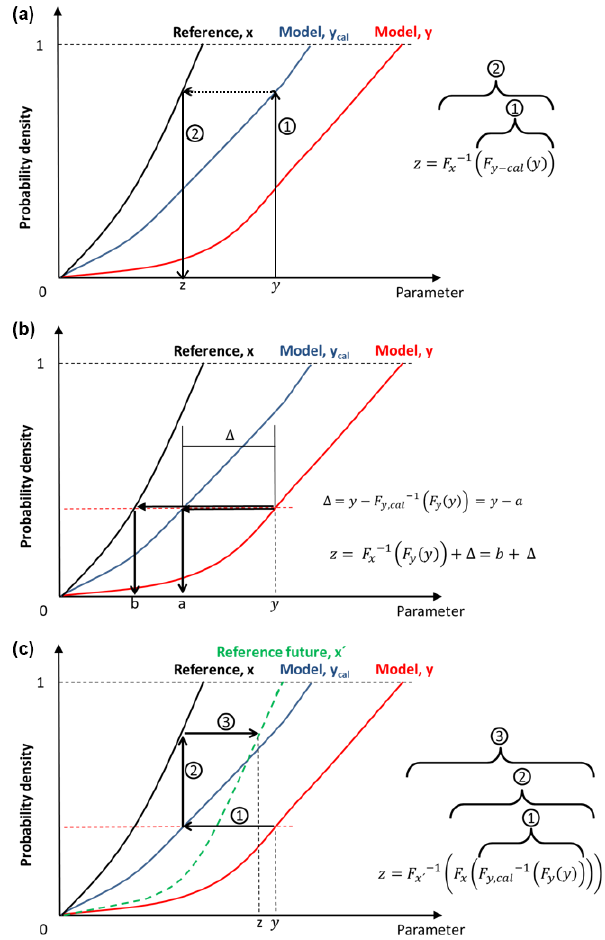
Figure 2. Descriptive visualization of the quantile mapping for (a) MIdAS, EQM, and DQM; (b) QDM; and (c) CDF-t. function is fitted to the 90 % most central data points of the Q–Q plot. The weights to the spline function are then de- fined according to the standard deviation of the data points from the linear fit. To avoid excessive weights for